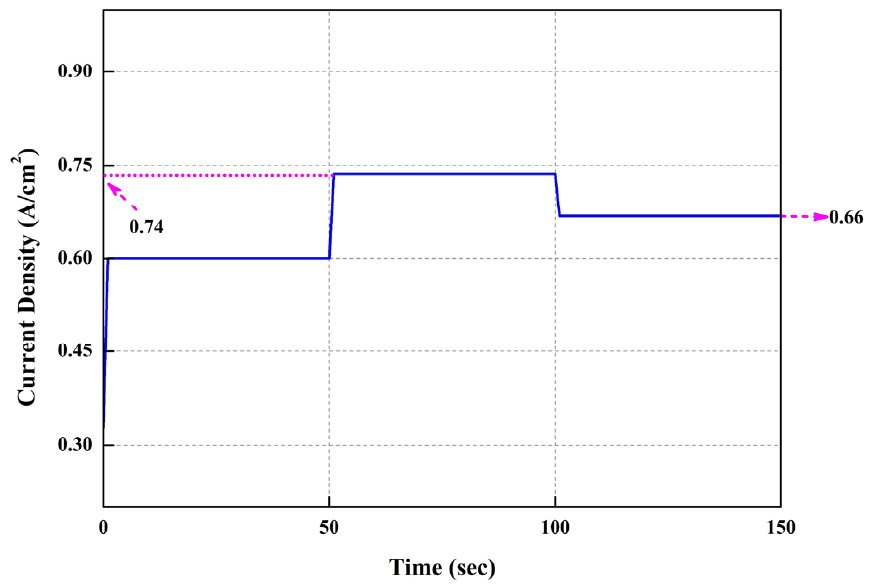
Figure 2. Scenarios of load profile (current density) in 150 s. Table 2. Implemented fault scenario.